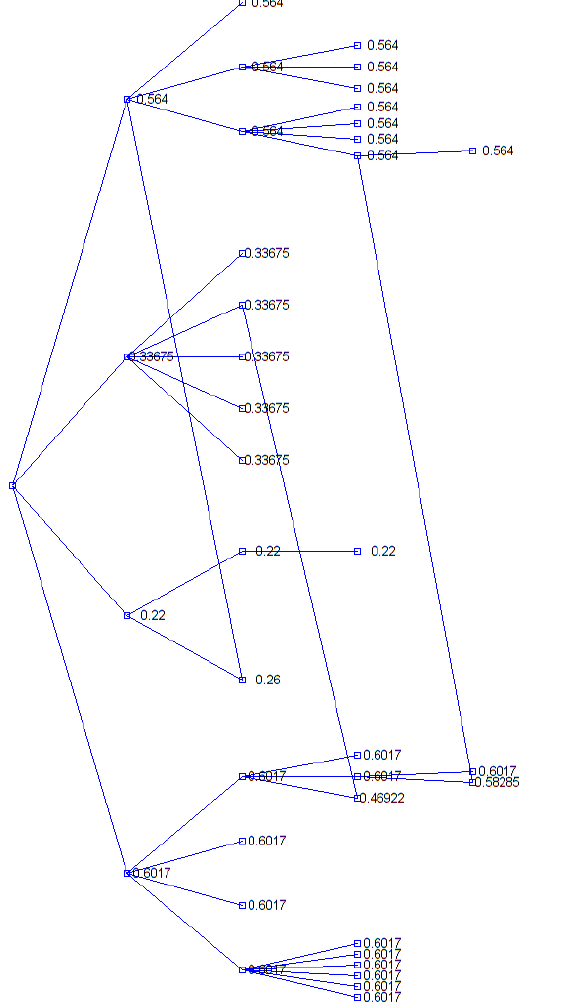
Figure 7. Updated user profile in third